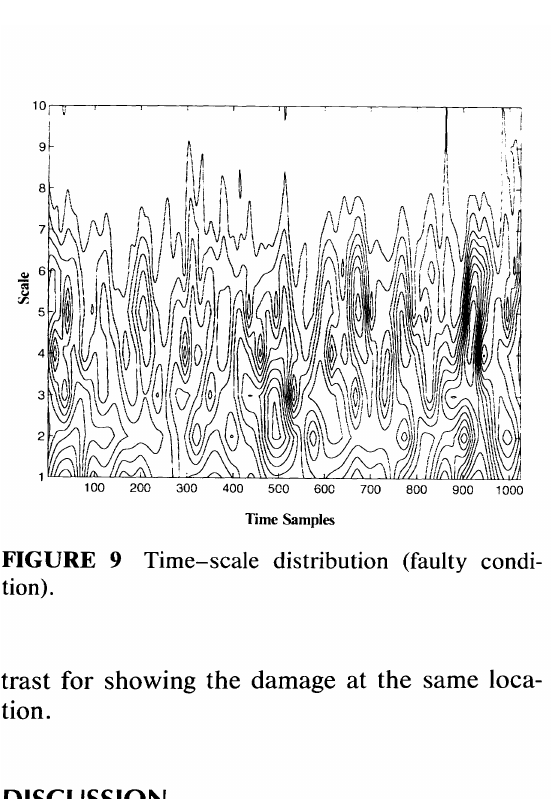
FIGURE 9 Time-scale distribution (faulty condi tion).